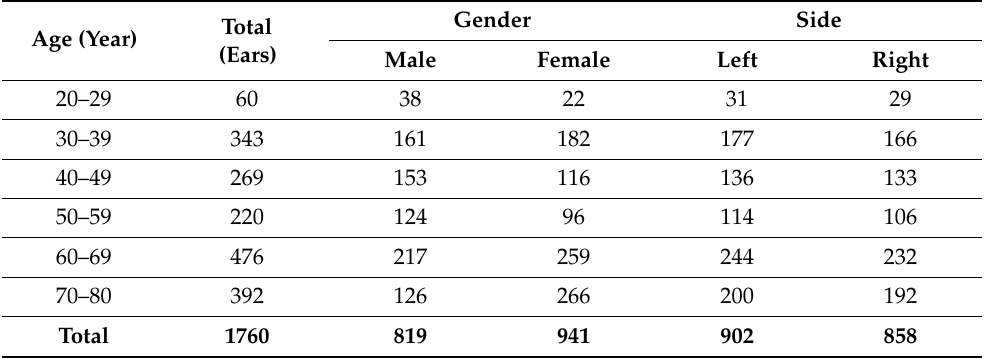
Table 1. The age (in years, y) and gender distribution of the audiogram data as counts of